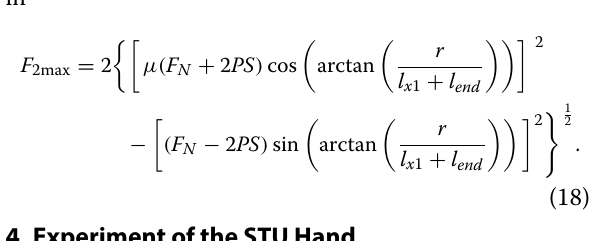
4 Experiment of the STU Hand